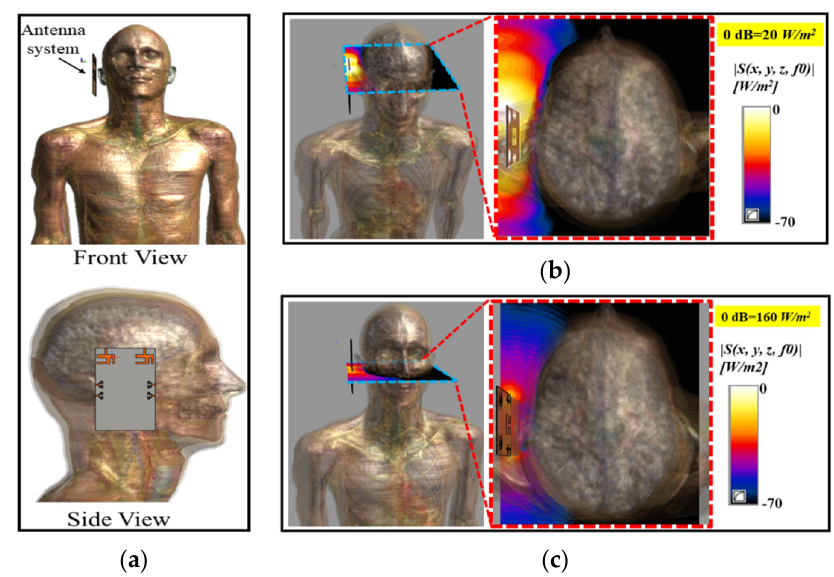
Figure 13. ( a ) Numerical Setup of Antenna, Front and Side View; ( b ) Spatial Power Density at 5.9 GHz; ( c ) Spatial Power Density at 28 GHz.